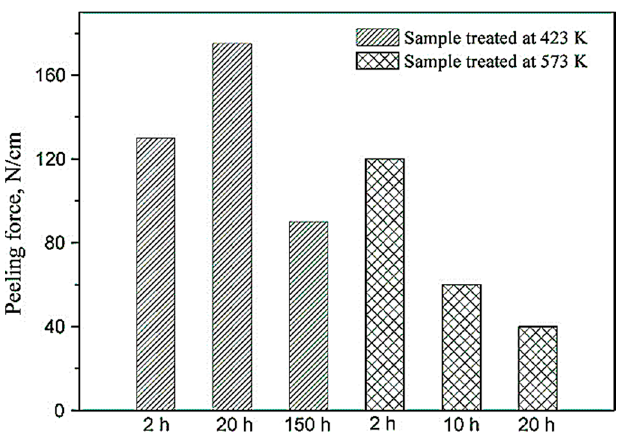
Figure 11. Peeling force of Cu/Al/Cu clad sheet with different heat treatment temperatures or times of heat processing [11].